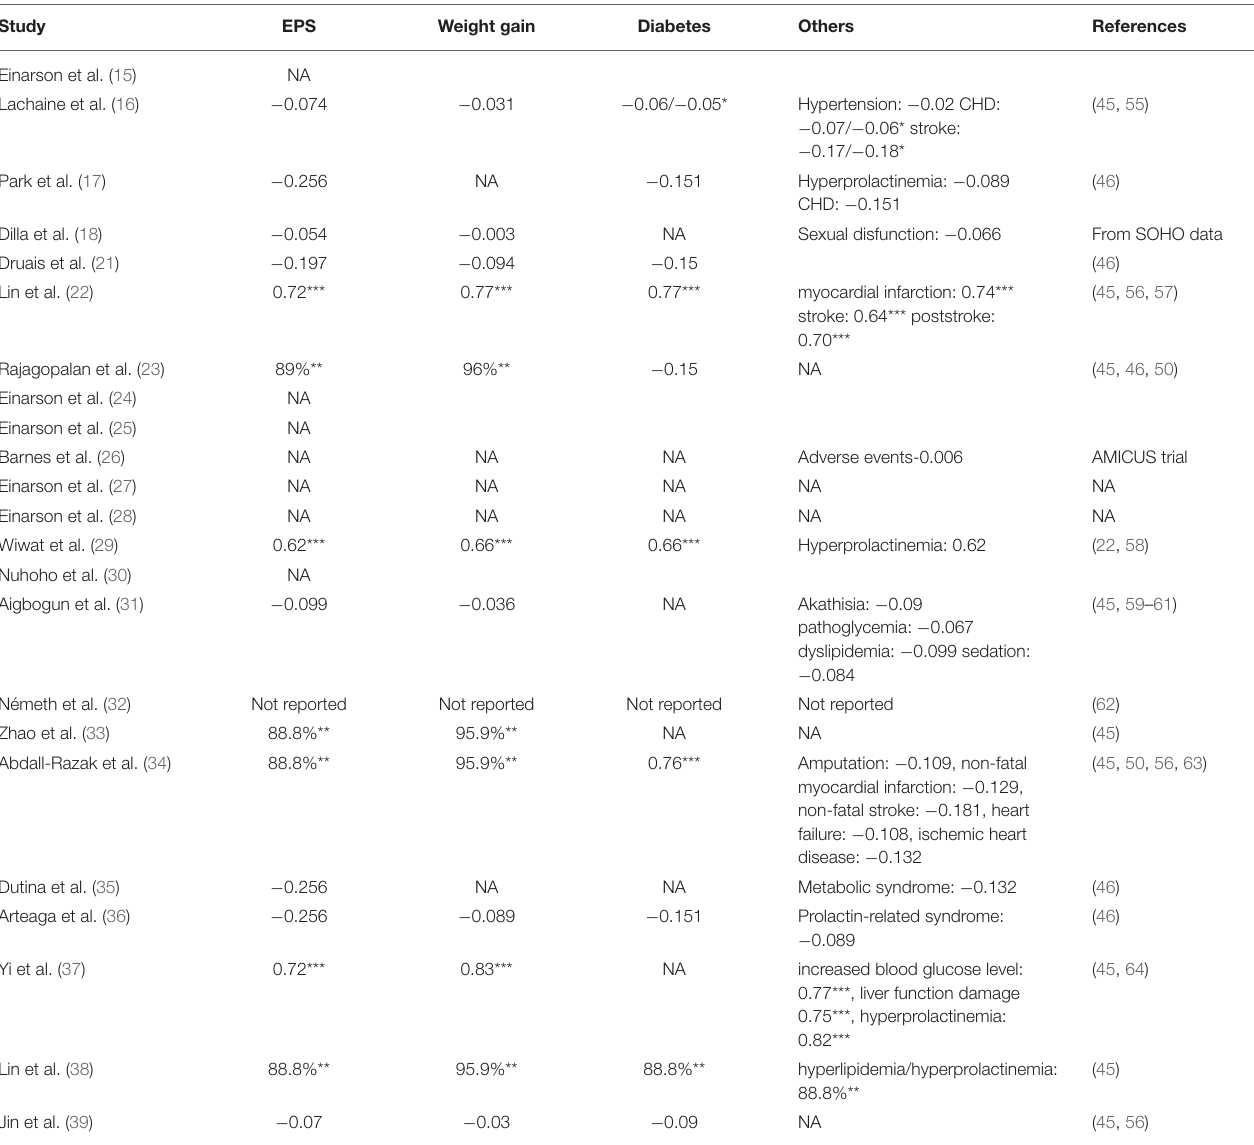
TABLE 7 | Summary of the utilities of adverse events or